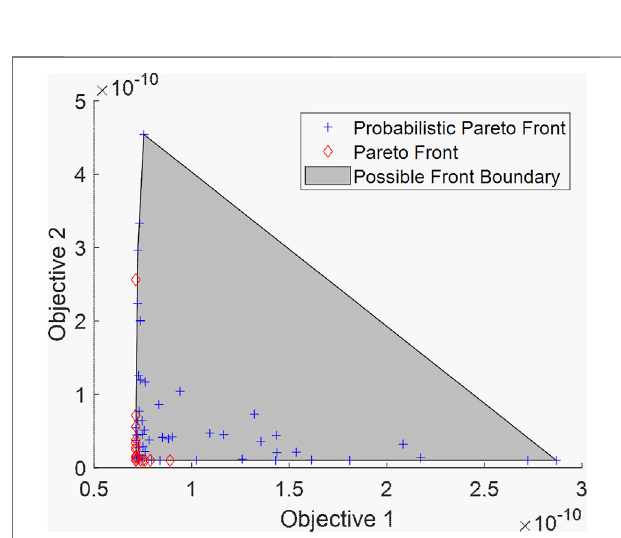
FIGURE 13 | Probabilistic Pareto front (case